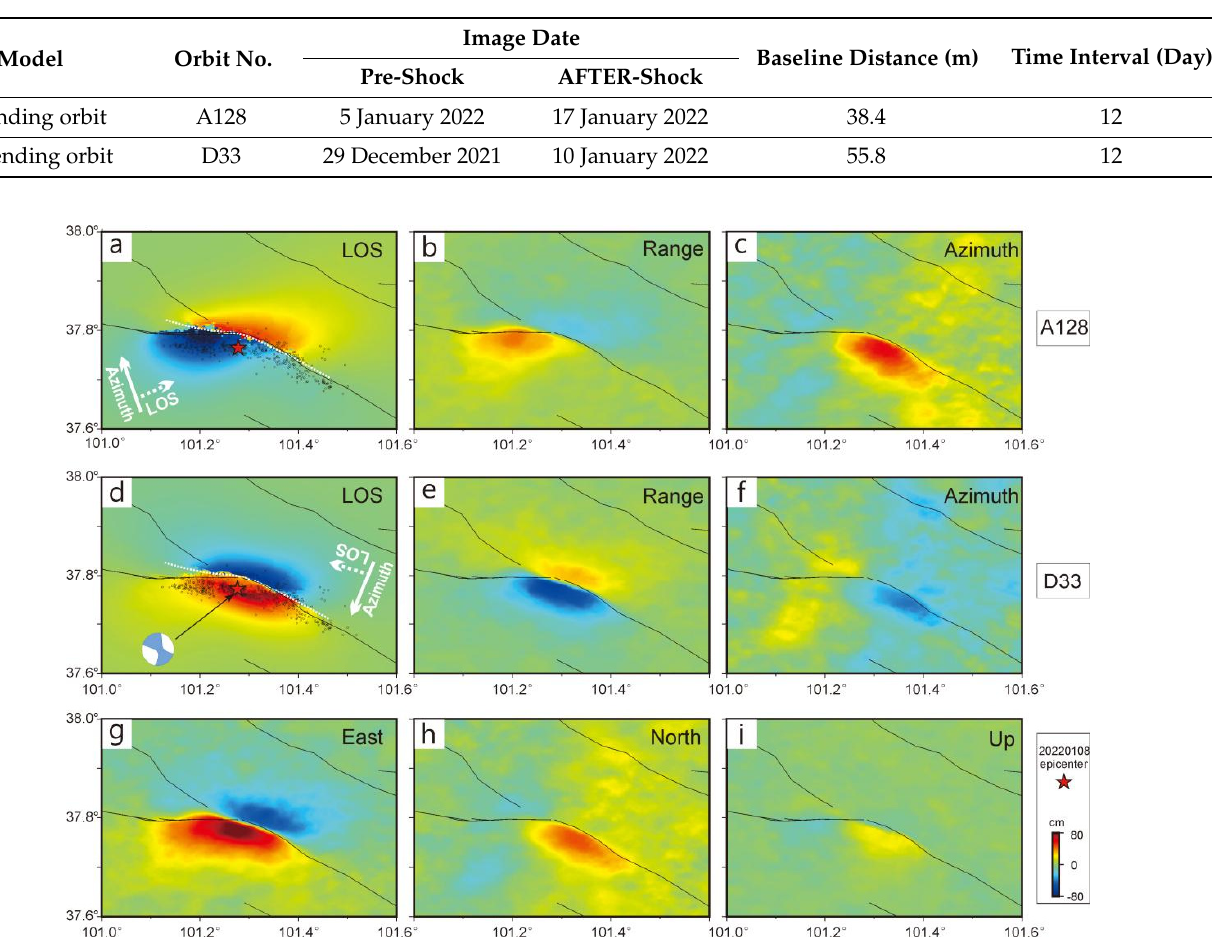
Figure 5. Coseismic deformation fields from InSAR data of the 2022 Menyuan M S 6.9 earthquake; ( a – c ) are the InSAR deformation field and the range and azimuth offset fields of ascending track (A128); ( d – f ) are the InSAR deformation field and the range and azimuth offset fields of descending track (D33). Black circles are the earthquake locations after relocation. Solid arrows indicate the satellite flight direction, and open arrows are the radar look directions. ( g – i ) Three components of the coseismic deformation field in an east-west direction, south-north direction, and vertical direction; the deformations eastward, northward, and upward are positive.